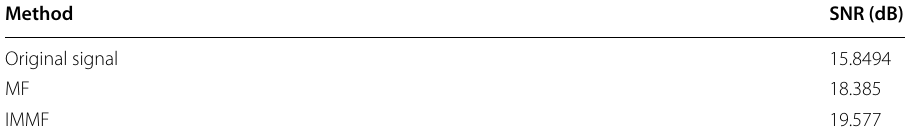
Table 2 Comparison of SNR of geomagnetic measurement signals after the first processing